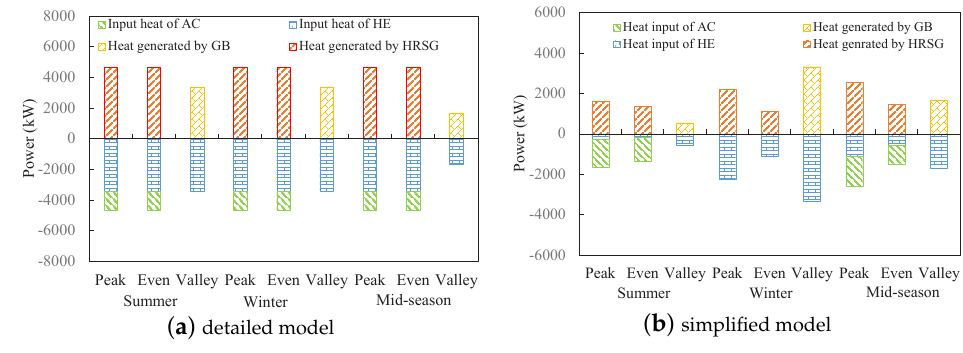
Figure 8. Heating optimization results as for Case 1.